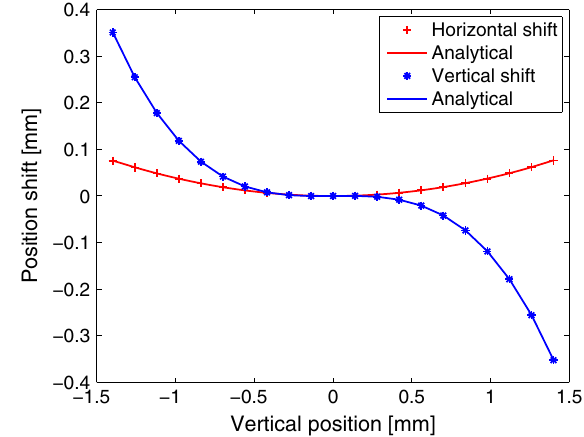
FIG. 3. Simulation of a vertical scan across the octupole field. The plots show the horizontal and vertical position shifts of the beam centroid due to octupole kicks and the fit of the analytical equations (5) and